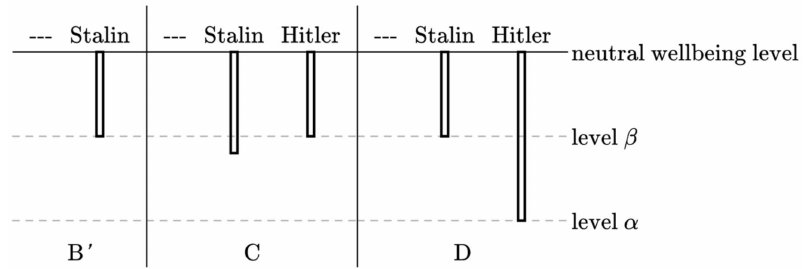
Figure 5. Conditional goodness of deserved